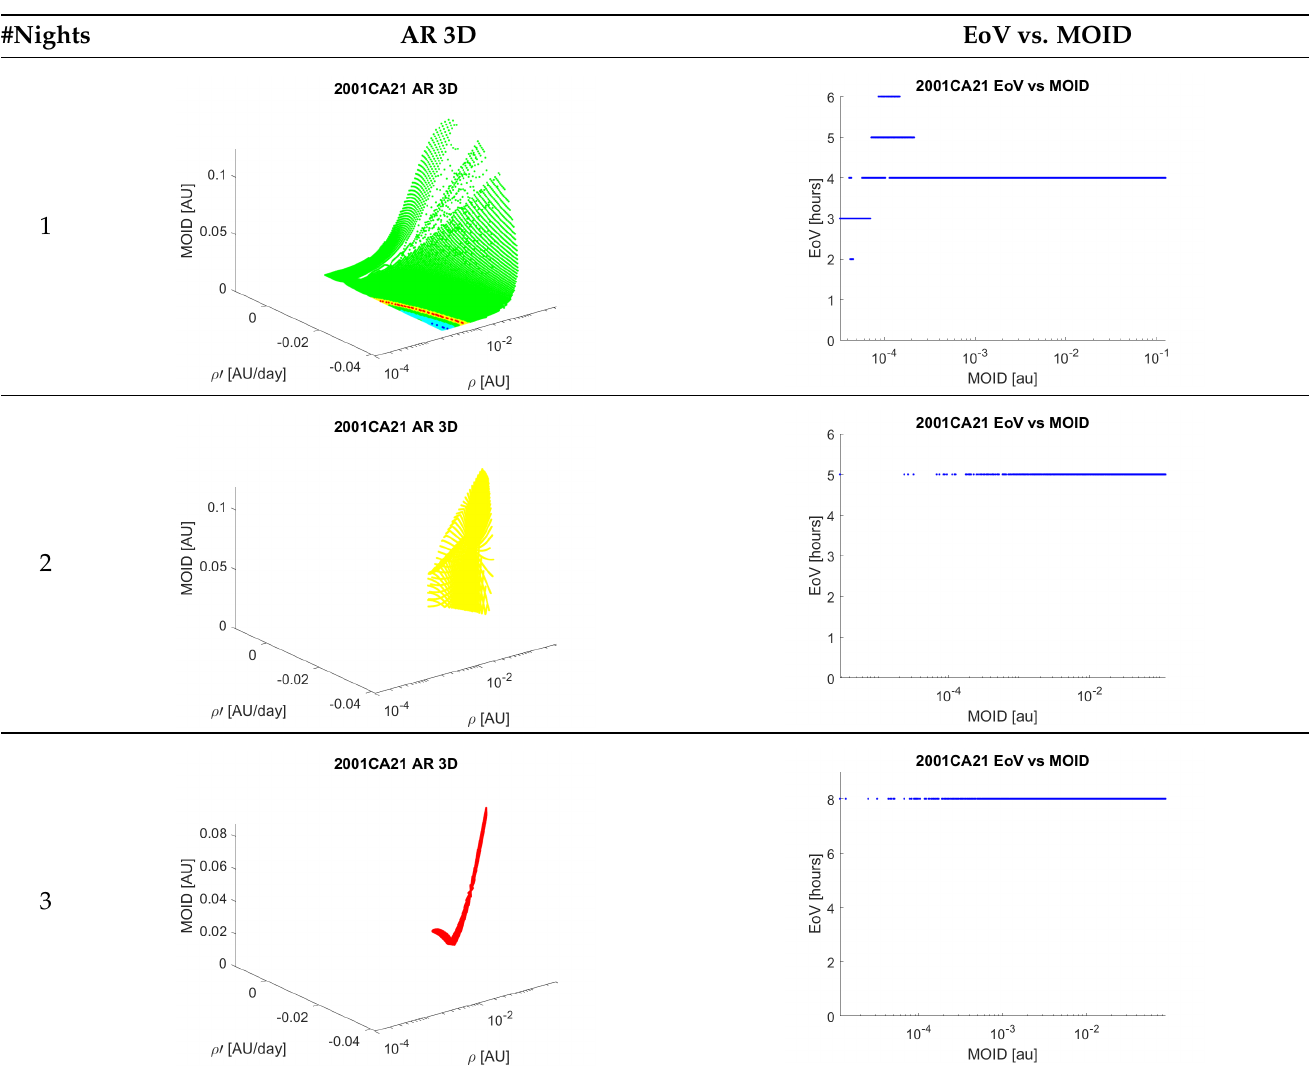
Table 4. Combination of the results of Tools 1 and 2 for each night of observation of asteroid 2001CA 21 . The second column contains the 3D representation of the AR, while in the third column each MOV point is represented on a MOID-EoV